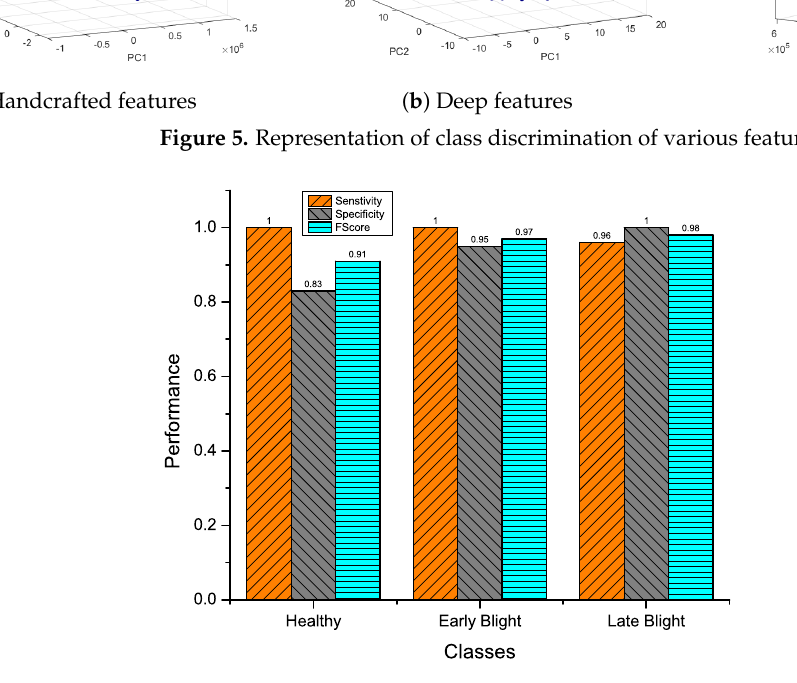
Figure 6. Performance evaluation of the proposed approach on test dataset.